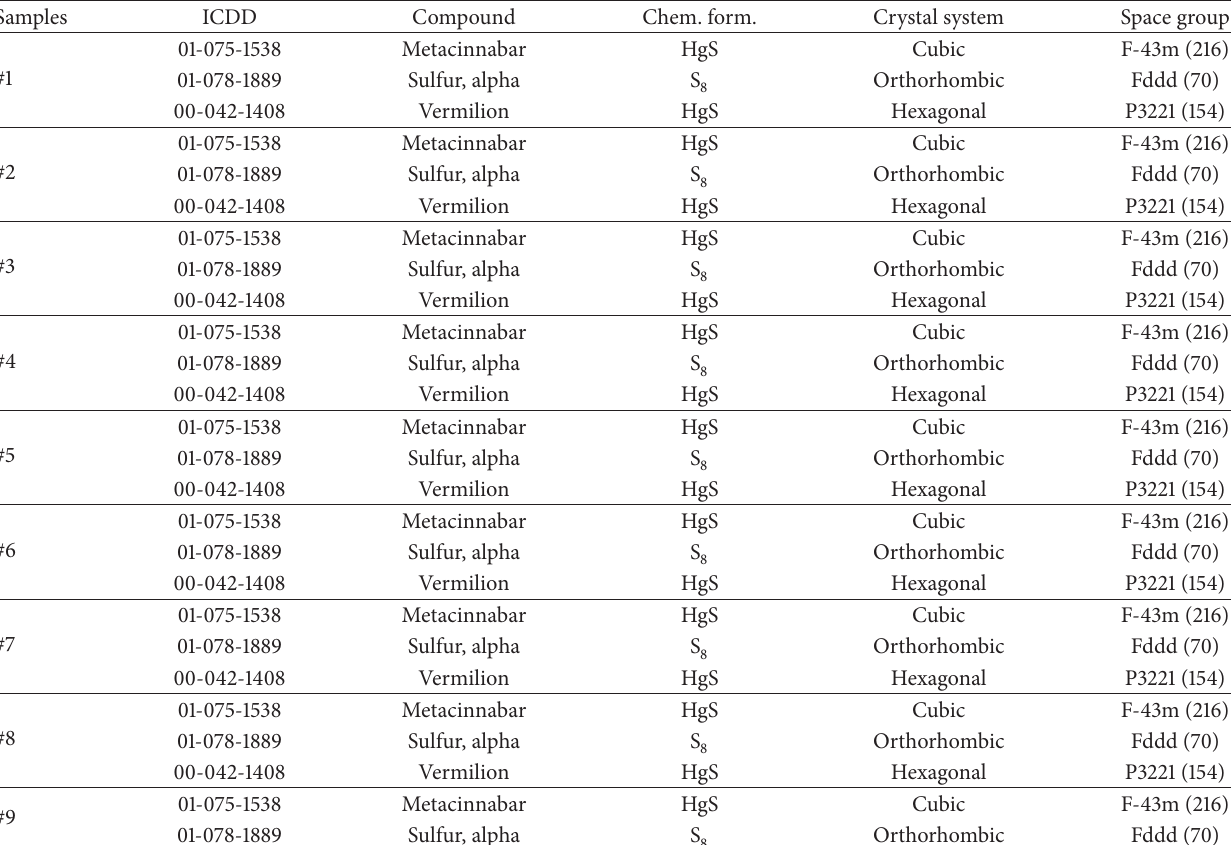
Table 3: Phase compositions in nine Zuotai samples by powder XRD.